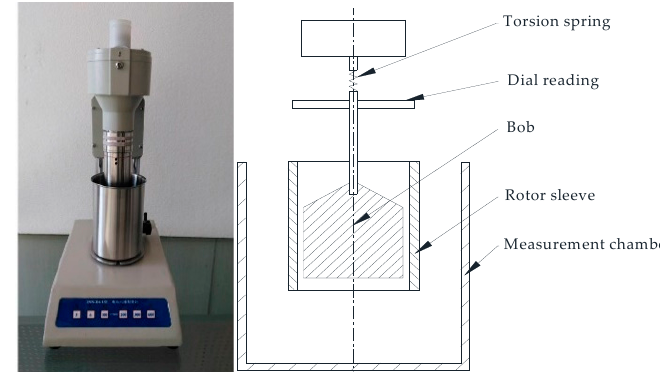
Figure 2. Standard rotational Couette viscometer.